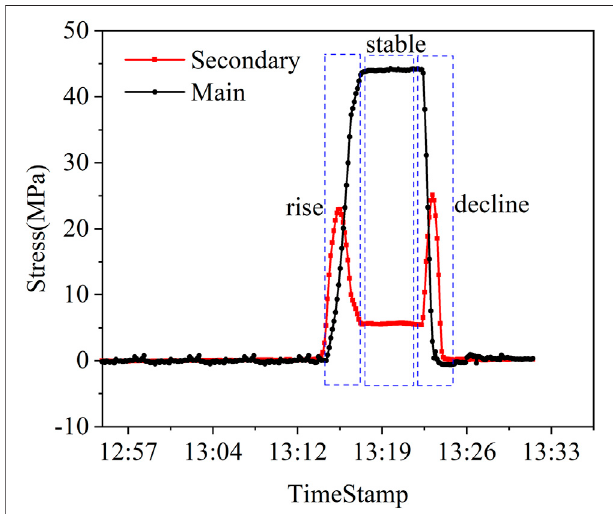
FIGURE 8 | The stress course of rods during the accuracy test.